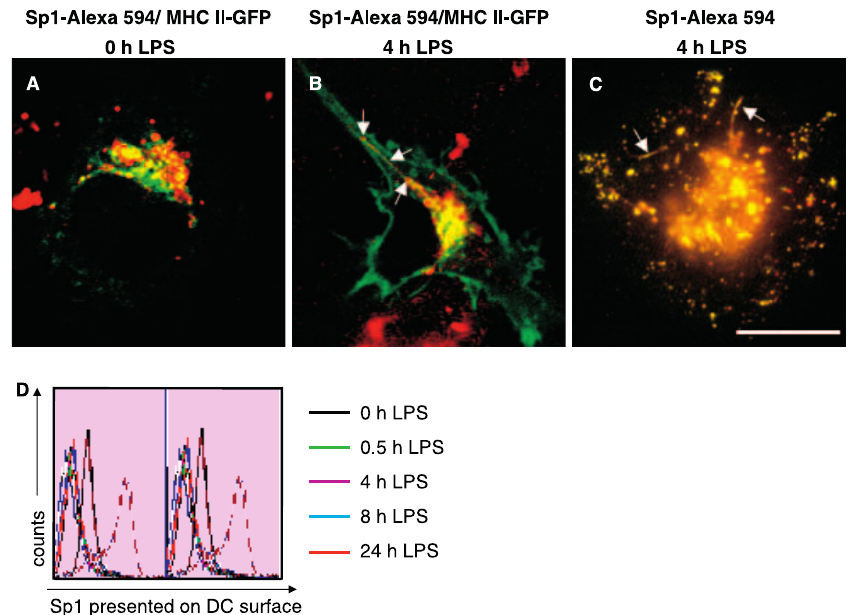
Figure 3. Export of Sp1 from Lysosomes to the Cell Membrane in MHCII-GFP–Positive Tubular Structures in Live DCs (A) iDCs transfected with MHCII-GFP were treated for 30 min with Sp1-Alexa 594 (500 l g/ml) and then analyzed by live cell imaging using confocal microscopy. In merged fluorescence images, Sp1 co-localizes extensively with MHCII in lysosomes. No MHCII is found on the cell surface. (B) iDCs transfected with MHCII-GFP were pre-incubated for 30 min with Sp1-Alexa 594 (500 l g/ml) and then treated with LPS for 4 h. Merged fluorescence live cell images of confocal microscopy demonstrate that Sp1/MHCII-positive tubular structures emanate from lysosomes in a perinuclear region and transit to the cell membrane. A single translocation Sp1/MHCII-positive tubule is labeled with white arrows (see Video S1). (C) iDCs previously transfected with MHCII-GFP and pre-incubated for 30 min with Sp1-Alexa 594 (500 l g/ml) were stimulated for 4 h with LPS. Combined TIR-FM/EPI microscopy reveals exit of Sp1-containing tubules from lysosomes (red) and their association with the plasma membrane (bright yellow). Tubules are labeled with white arrows (see Video S2). Scale bar, 10 l m. (D) After treatment with Sp1-biotin for 30 min, iDCs were incubated for various time intervals with LPS, and their cell surface was stained with FITC- conjugated streptavidin. Presentation of Sp1-biotin on the DC surface was quantified by flow